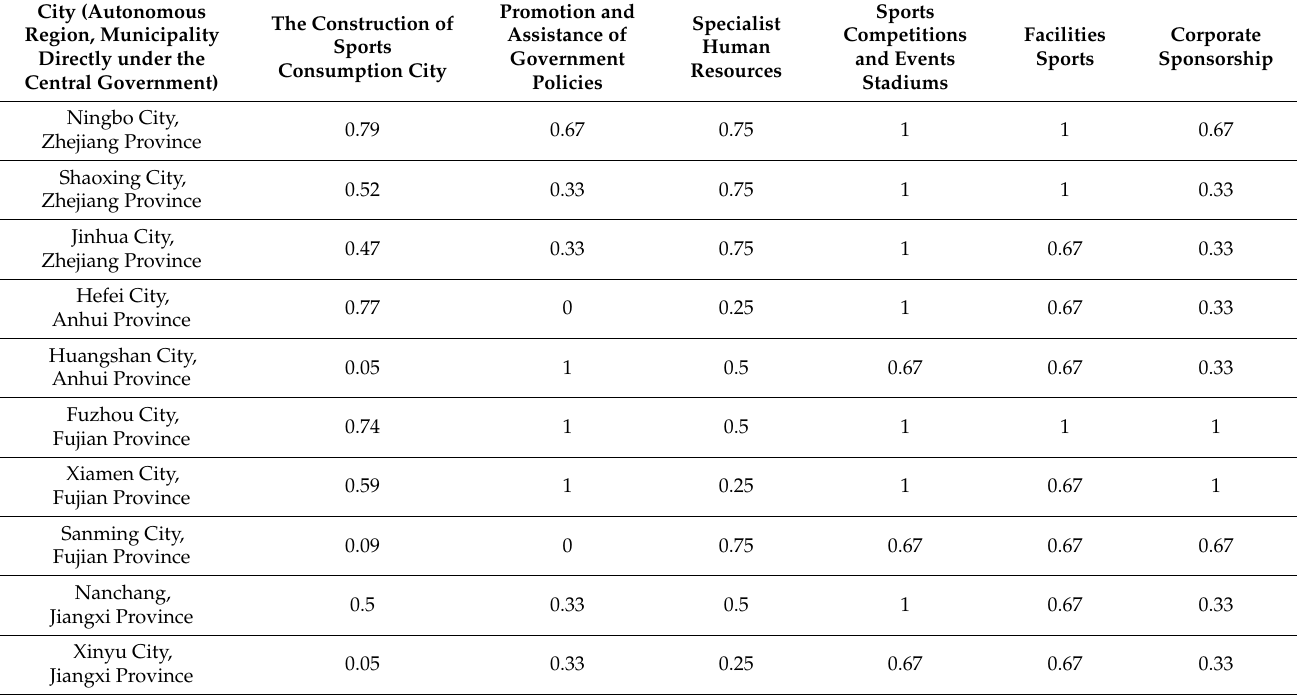
Table 2. The truth table for the long-term growth of sports-consuming cities (partial).